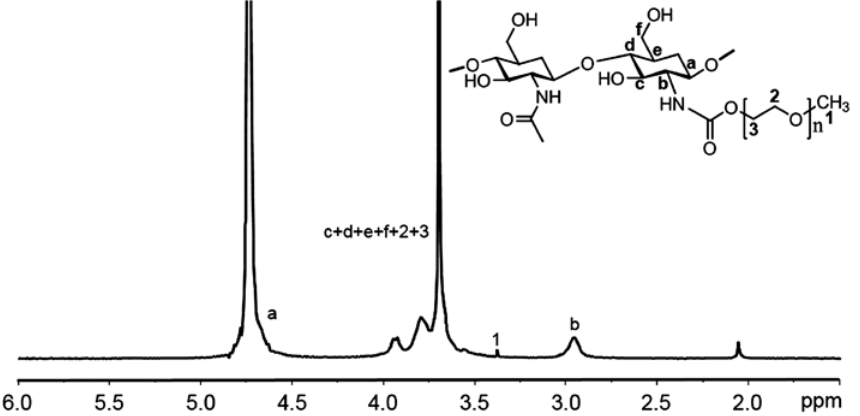
Figure 1: 1 H NMR spectrum of CTS-mPEG.